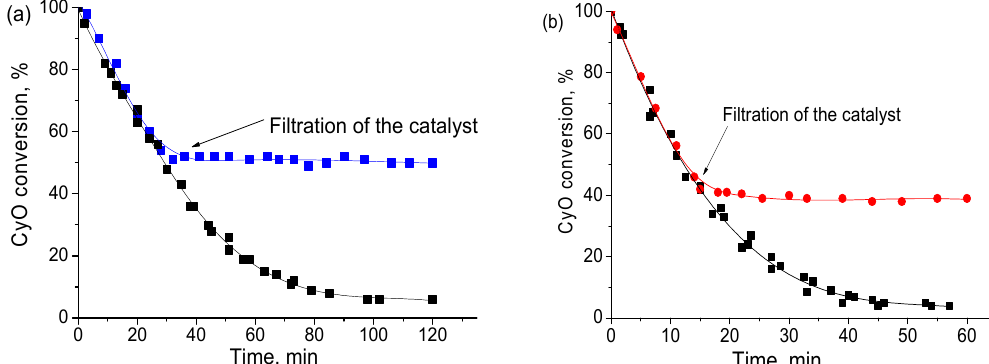
Figure 13. Hot catalyst filtration test for CyO oxidation with H 2 O 2 over ( a ) 15 wt. % NbW 5 /CNTs and ( b ) 15 wt. % PW 4 /CNTs. Reaction conditions: [CyO] = 0.1 M, [H 2 O 2 ] = 0.2 M, 15 wt. % POM/CNTs 10 mg (0.7 μ mol PW 4 , 0.8 μ mol NbW 5 ), DMC 1 mL, 50 °C. Evaluation of the 15 wt. % PW 4 /CNTs and 15 wt. % NbW 5 /CNTs catalysts